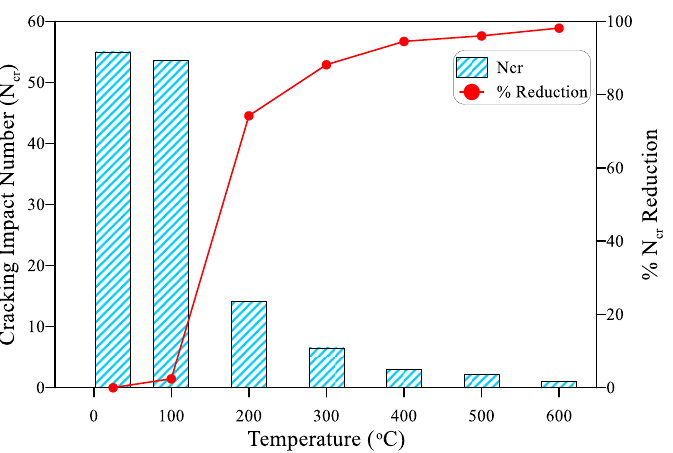
Figure 10. Cracking impact number and its percentage reduction at different temperatures.